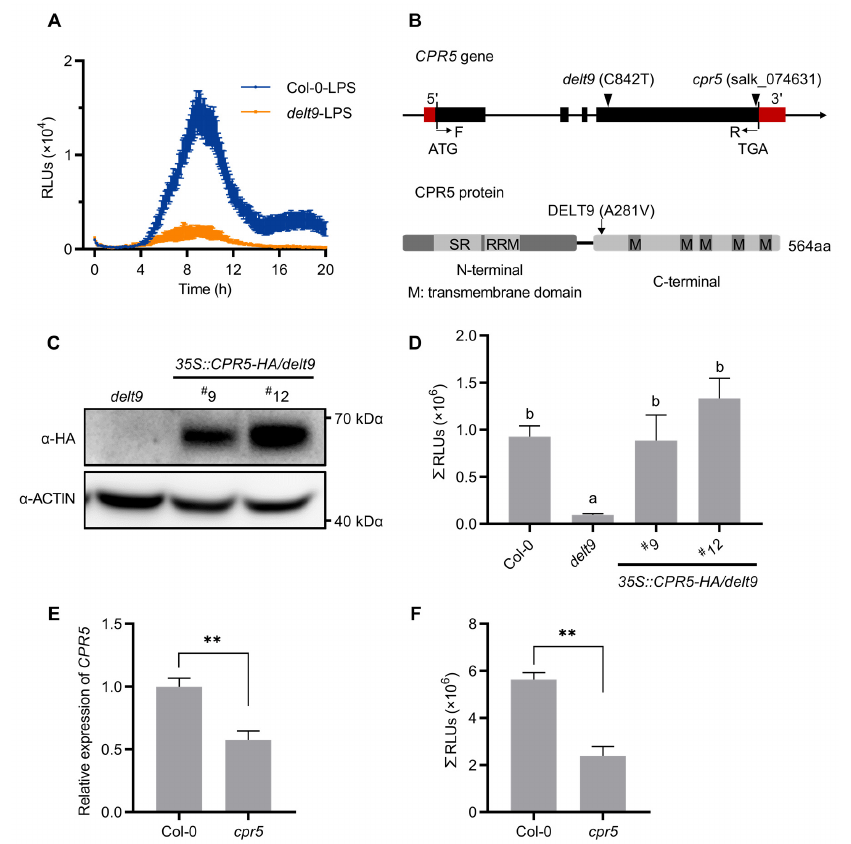
Figure 1. cpr5 mutants show reduced luminol-emitted light signals after treatment with lipopolysac- charides (LPS). ( A ) The kinetics of luminol-emitted light signals after LPS treatment. Leaf disks from 3-week-old wild-type (Col-0) and delt9 mutants were treated with 50 µ g/mL LPS with the addition of luminol. Luminol-emitted light signal kinetics were recorded for 20 h. Data are the mean ± standard error (SE; n = 8). ( B ) Schematic representation of CPR5 . Mutations in delt9 and T-DNA insertion sites in cpr5 are indicated. Black boxes, thin lines, and red boxes represent exons, introns, and untranslated regions (UTRs), respectively. Point mutation sites in delt9 and T-DNA insertion sites are indicated by triangles. ( C ) CPR5-HA protein levels in two independent 35S::CPR5-HA / delt9 transgenic lines. Total proteins were extracted from 7-day-old seedlings and detected via immunoblotting using an α -HA antibody. Actin served as a loading control. ( D ) Luminol-emitted light signals in 35S::CPR5-HA / delt9 transgenic lines. Experimental conditions were the same as those used in ( A ). Total photon count for 20 h is shown. Data are means ± SE (n = 8). Letters above bars indicate significantly different values between groups ( p ≤ 0.05; one-way analysis of variance [ANOVA]). ( E ) Transcript levels of CPR5 . Total RNA was extracted from 4-week-old leaves. Transcript levels were detected by RT-qPCR, and ACTIN7 was the reference gene. Asterisks indicate significant differences between cpr5 and Col-0 (** p ≤ 0.01; Student’s t -test). ( F ) Luminol-emitted light signals in cpr5 mutants. Experimental con- ditions were same as those used in ( A ). Data are means ± SE (n = 8). Asterisks indicate significant differences between cpr5 and Col-0 (** p ≤ 0.01; Student’s t